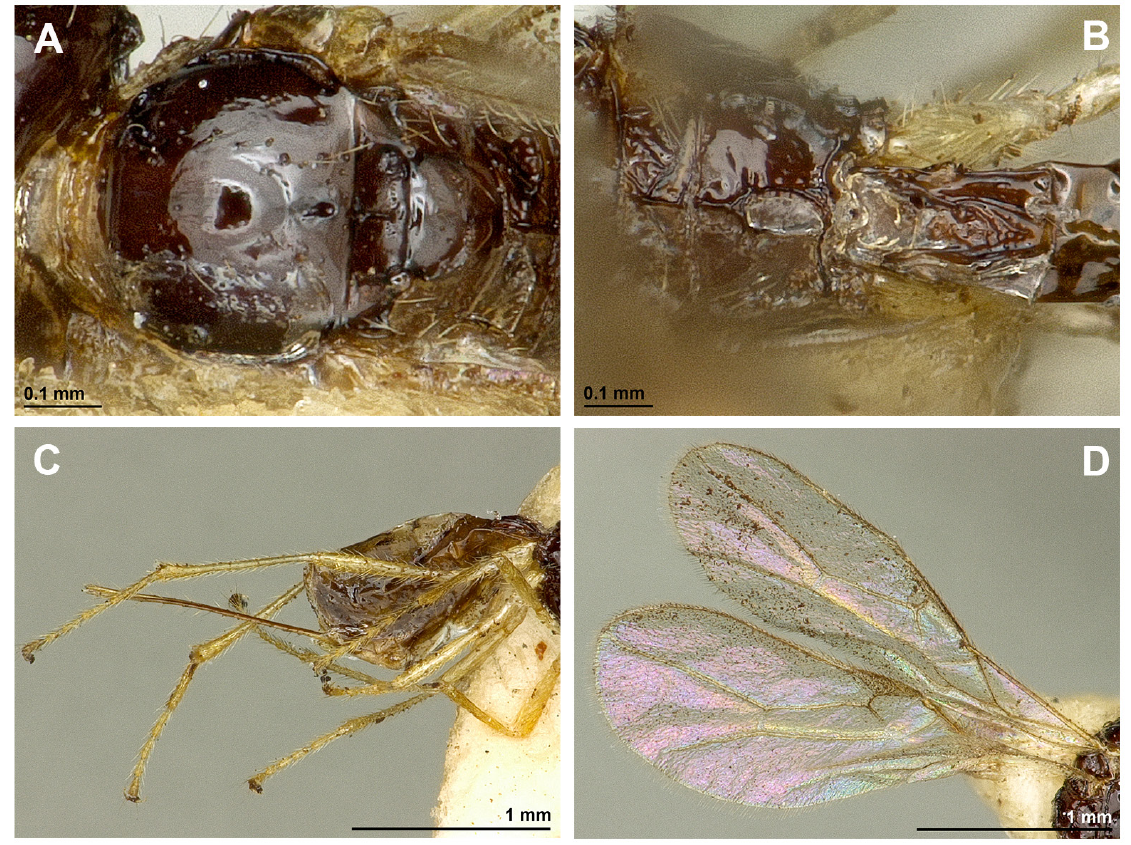
Fig. 81. Asobara zululana Peris-Felipo, sp. nov., ♀, holotype (BMNH 1926-277). A . Mesoscutum, dorsal view. B . Propodeum and first metasomal tergite, dorsal view. C . Hind leg, metasoma and ovipositor, lateral view. D . Fore and hind